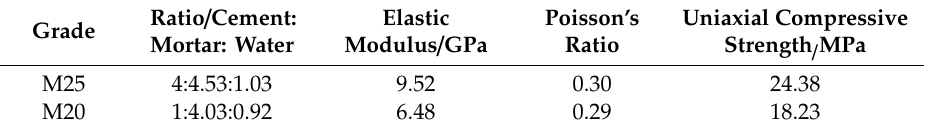
Table 2. Average value of cement mortar obtained from uniaxial compression tests.